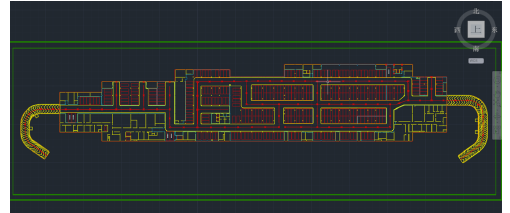
Figure 12. The layout diagram of BLE in underground parking garage (Red Dot: BLE base station)